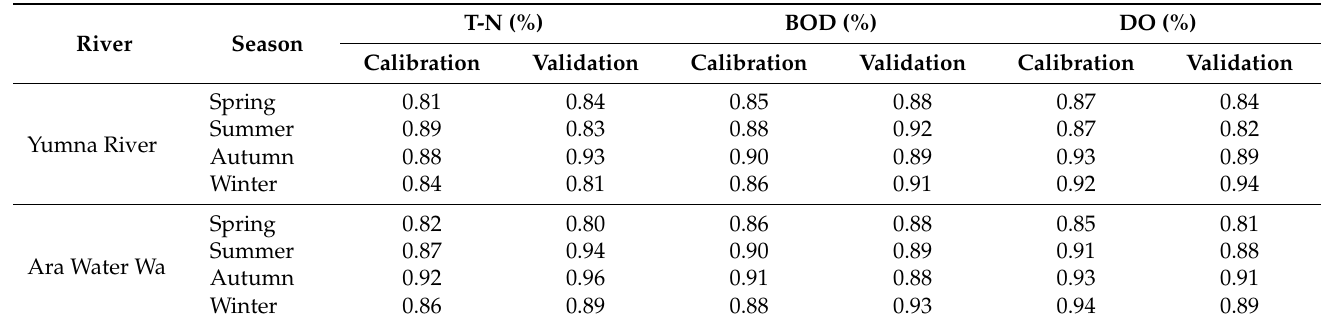
Table 3. Fitting level assessment of the WASP8 outcomes with R 2